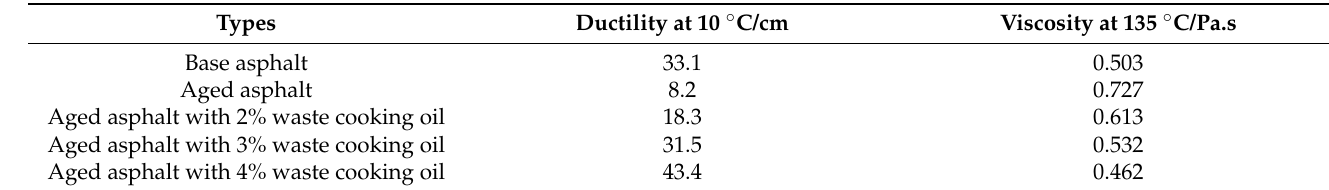
Table 8. Viscosity and ductility of different asphalt [37].